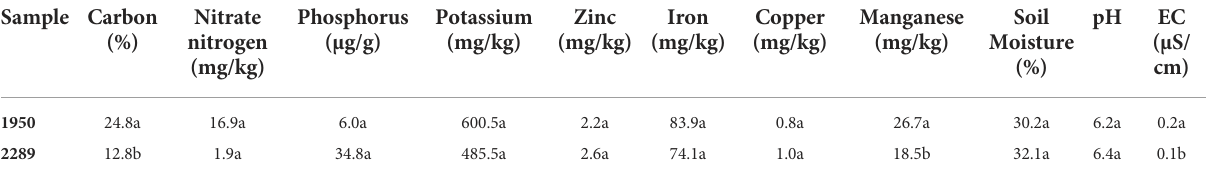
TABLE 3 Native soil characteristics from both elevations. Sample Carbon